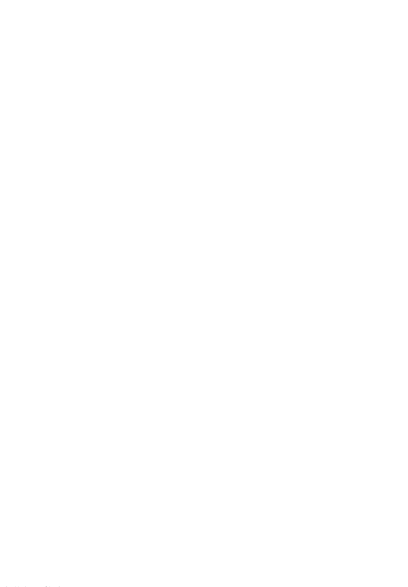
Table 3. Distribution of macro-haplogroups in case and control